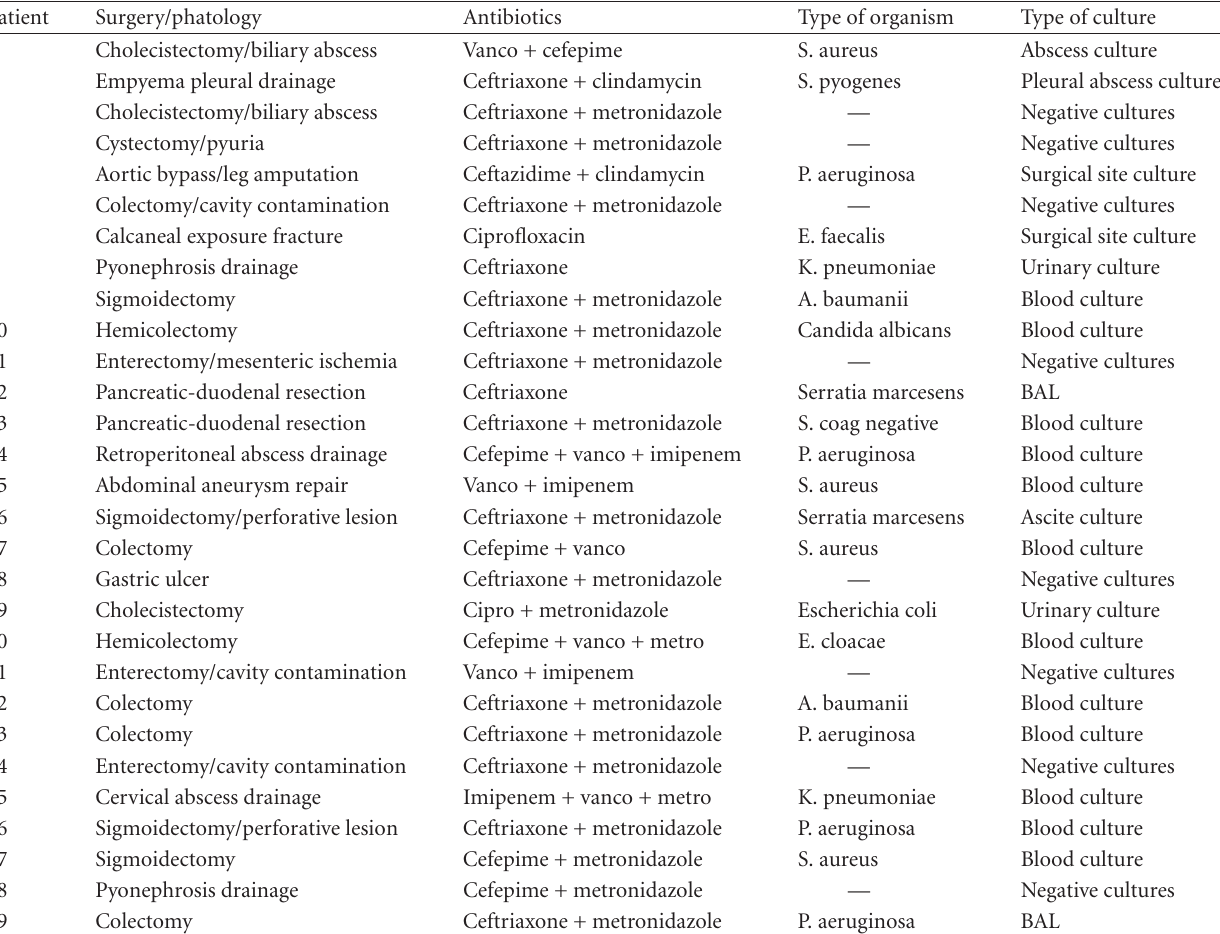
Table 2: Microbiological characteristics of patients.